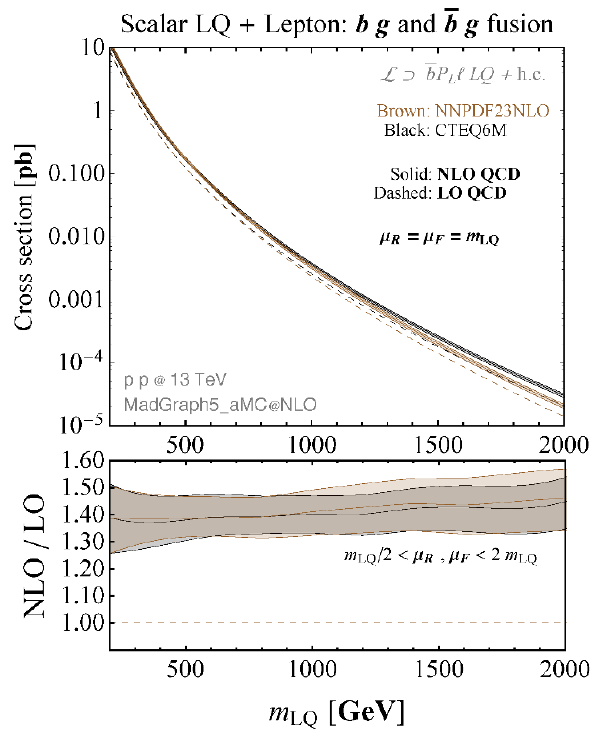
Figure 3 . Total inclusive single LQ + lepton production cross sections (from bottom (cid:13)avour) at the NLO in QCD (upper panel) and ratio of NLO and LO cross sections (lower panel) for the proton-proton collisions for the NNPDF23NLO [33] and CTEQ6M [34] sets at 13 TeV center-of-mass energy as a function of the LQ mass m LQ . The LQ coupling strength to bottom quark and lepton is set to one ( y b‘ =